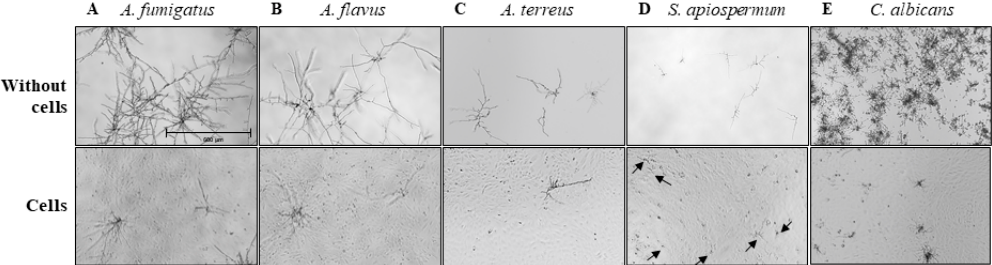
Figure 3. Microscopic observations of fungal growth by clinical isolates of A. fumigatus ( A ), A. flavus ( B ), A. terreus ( C ), S. apiospermum ( D ) and C. albicans ( E ) in the absence ( top ) or presence ( bottom ) of BEC after 15 h of infection (magnification, 40×). Black arrows indicate filaments of S. apiospermum cultured with BEC ( D ).